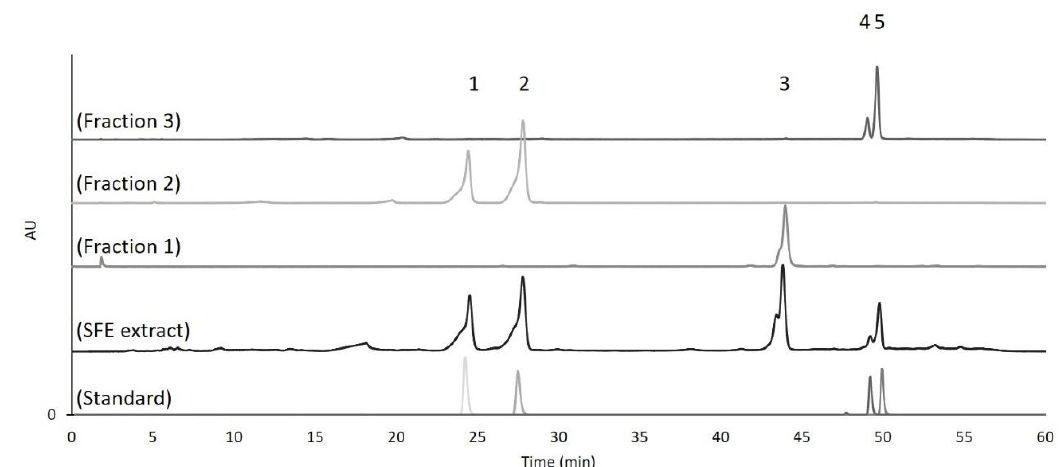
Figure 6. HPLC-DAD chromatograms ( λ = 480 nm) of standards (numbers represent the different SL obtained in the corresponding fraction: 1-11 β ,13-dihydrolactucin; 2-Lactucin; 3-8-deoxylactucin and 11 β ,13-dihydro-8-deoxylactucin; 4-11 β ,13-dihydrolactucopicrin; 5-Lactucopicrin), the best SFE extract (350 bar, 40 ◦ C, 10% EtOH as co-solvent and 15 g/min flow rate during 120 min) and the three different fractions obtained by flash chromatography using Silica gel 60 mesh as stationary phase and Dichloromethane:Methanol (95:5 v / v ) as mobile phase.